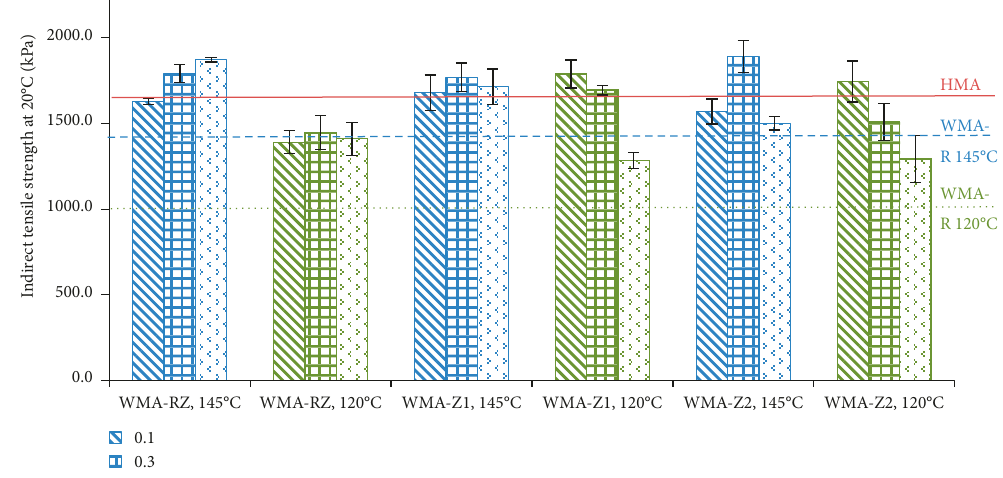
Figure 5: Effect of zeolite type and dosage on indirect tensile strength of